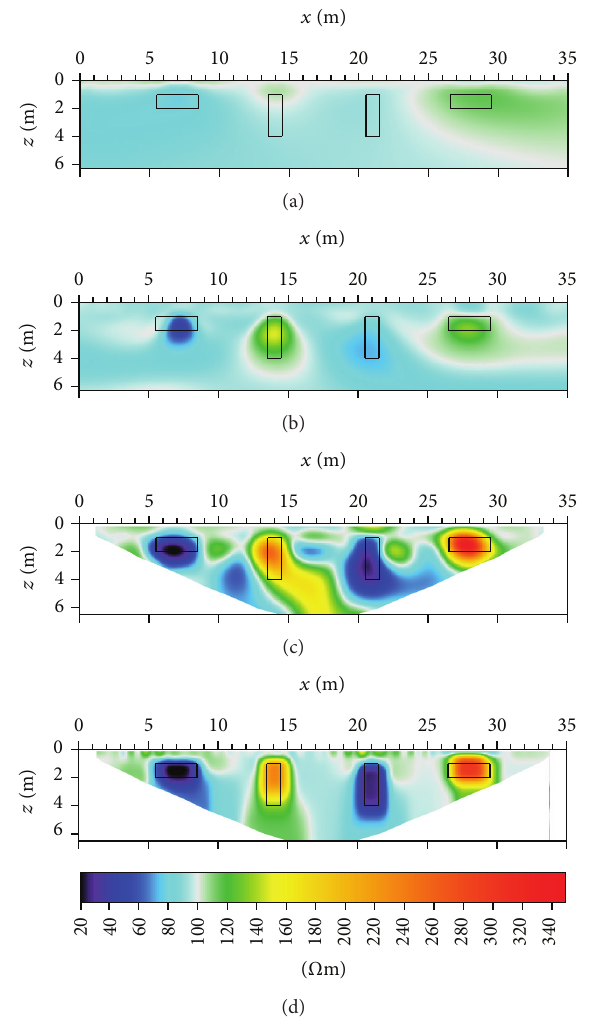
Figure 8: Back-projection, fast imaging, and inversions on data simulated starting from a model with four prisms of different shapes and resistivities (resp., 1000 Ω m the resistive ones and 10 Ω m the conductive ones), buried in a homogeneous medium (100 Ω m). A comparisonismadebetweentheback-projectionobtainedusingthe transposed of matrix B (a), the image obtained by a damped least- squares solution of the filtered sensitivity matrix (b), the standard least-squares constrain inversion (c), and robust data constrain inversion (d). The color scales are the